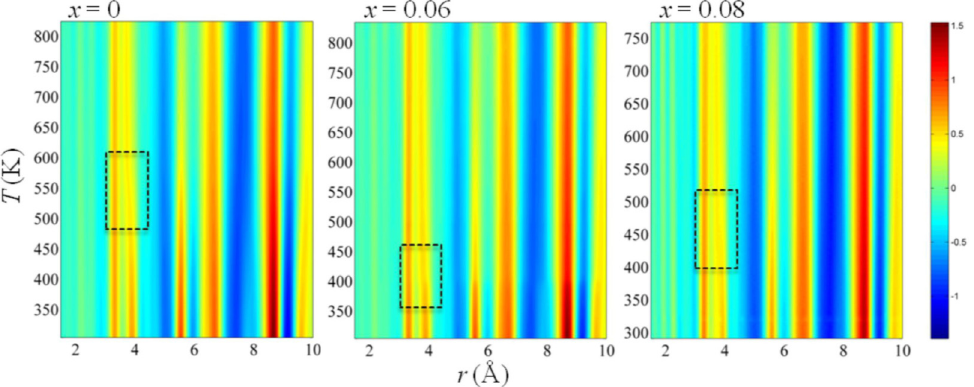
Figure 6. Temperature evolution of X ‐ ray PDF intensities for BNBT for x = 0, 0.06, and 0.08; the dashed rectangles mark the temperature ranges of the most pronounced changes in PDFs. Reproduced with permission from [39].